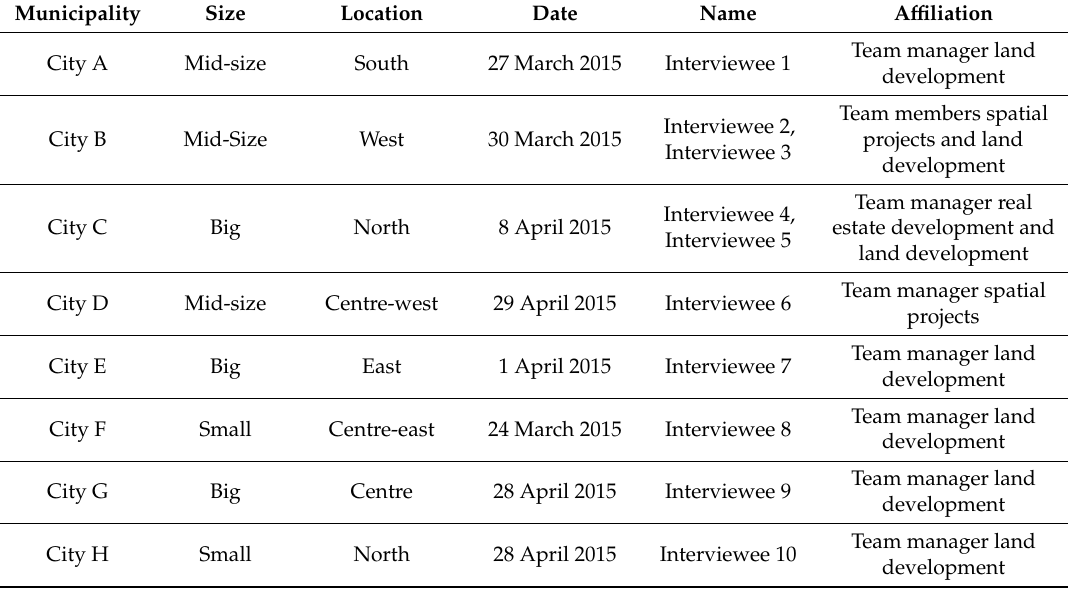
Table 2. Overview of